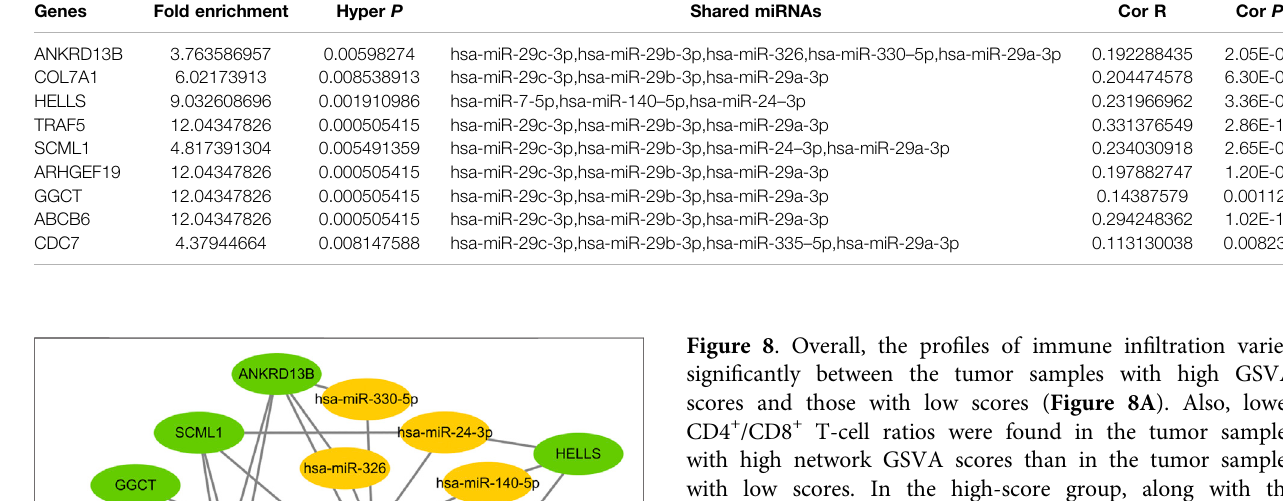
TABLE 2 | Hypergeometric test and Correlation analysis for mRNAs selection. Genes Fold enrichment Hyper P